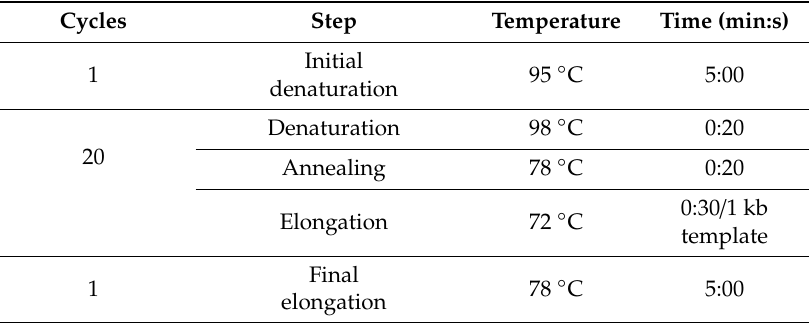
Table 2. Site directed mutagenesis